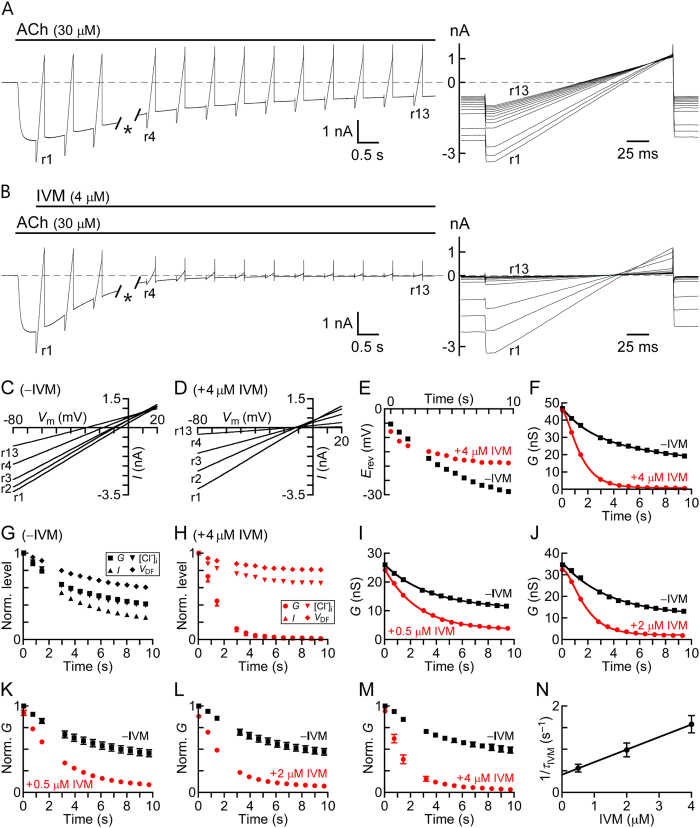
Chloride conductance of α7-GluClβRs.Representative whole-cell current traces elicited by: (A) ACh alone and (B) ACh to which IVM was added after the current peak. Recordings were performed at −60 mV with intervening 200-ms-long voltage ramps applied from −80 to +20 mV during the current decline, giving output currents r1–r13. *, time lapse of ~1 sec between protocols’ exchange (see “Supplementary Materials and Methods”). Traces in A and B were recorded from the same cell, with an intermediate 74-sec-long wash. Right panels show superimposition of the output currents. (C,D) Current-voltage (I/V) relations extracted from A and B, respectively (r13 in D overlaps the x-axis). (E) Reversal potentials (Erev) extracted from the voltage-ramps’ output currents of A (black squares) and B (red circles), plotted as a function of time (0 sec, time of r1). (F) Decay of chloride chord conductance plotted as a function of time, in the absence or presence of IVM. The conductance points were calculated at −65 mV based on the voltage-ramps’ output currents shown in A and B. Exponential fits (Eq. 6) are shown. (G,H) Normalized (Norm.) conductance (G), current (I), intracellular Cl− ion concentration ([Cl]i), and electrochemical driving force (VDF) plotted as a function of time for ACh-dependent responses in the absence (panel G) or presence (panel H) of IVM (relating to responses in A and B, respectively). (I,J) Decay of chloride chord conductance plotted as a function of time in representative cells exposed to different IVM concentrations. (K,L,M) Averaged normalized chloride chord conductance (Norm. G) plotted as a function of time under different IVM concentrations. In each cell, each conductance was normalized to the conductance extracted from r1 of the ACh-alone application. N = 7, 11 and 8 in K, L and M, respectively. Error bars are SEM. (N) 1/τIVM plotted as a function of IVM concentration, using equation 7 for curve fitting by linear regression (r2 = 0.999). 26 cells were analyzed to obtain the averaged 1/τIVM points. Error bars are SEM. In all panels, ACh concentration is 30 μM.